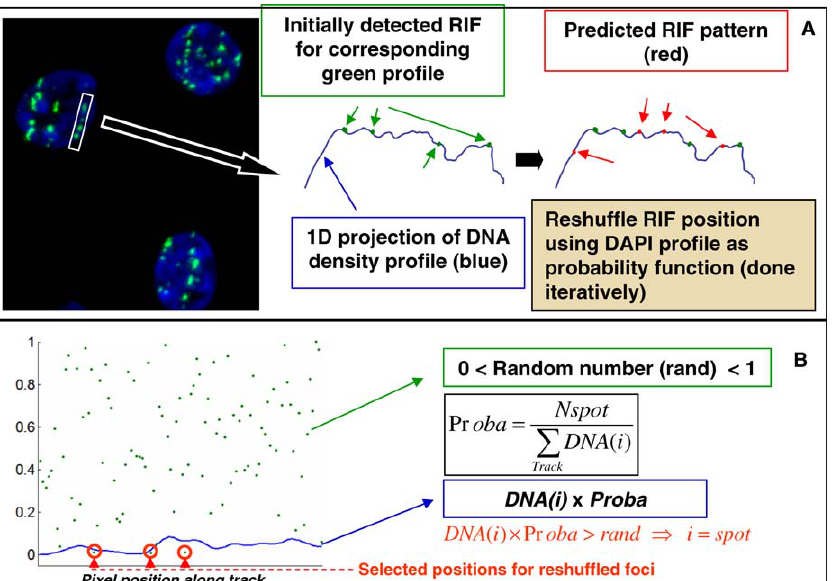
Figure 2. Illustration of Image Manipulation to Predict the Average DNA Damage Pattern along a Track for a Given DNA Density Profile (A) Shows a typical image of cells that have been traversed with 1 Gy of 1 GeV/amu Fe ions. After manually selecting a region that contains a clear track, foci identification and reshuffling is done as depicted by the cartoon. Foci detection is done automatically via in-house image algorithm (see Materials and Methods). (B) Further illustrates the mathematical approach used (i.e., Monte Carlo concept), where the probability of damage at a pixel location is proportional to the DNA density at the same location. This process is done iteratively (i.e., 50 randomizations per nucleus analyzed) to give a reasonable average break distribution. For each iteration, RIF position is determined by a probability less than that determined by DNA density (blue line).